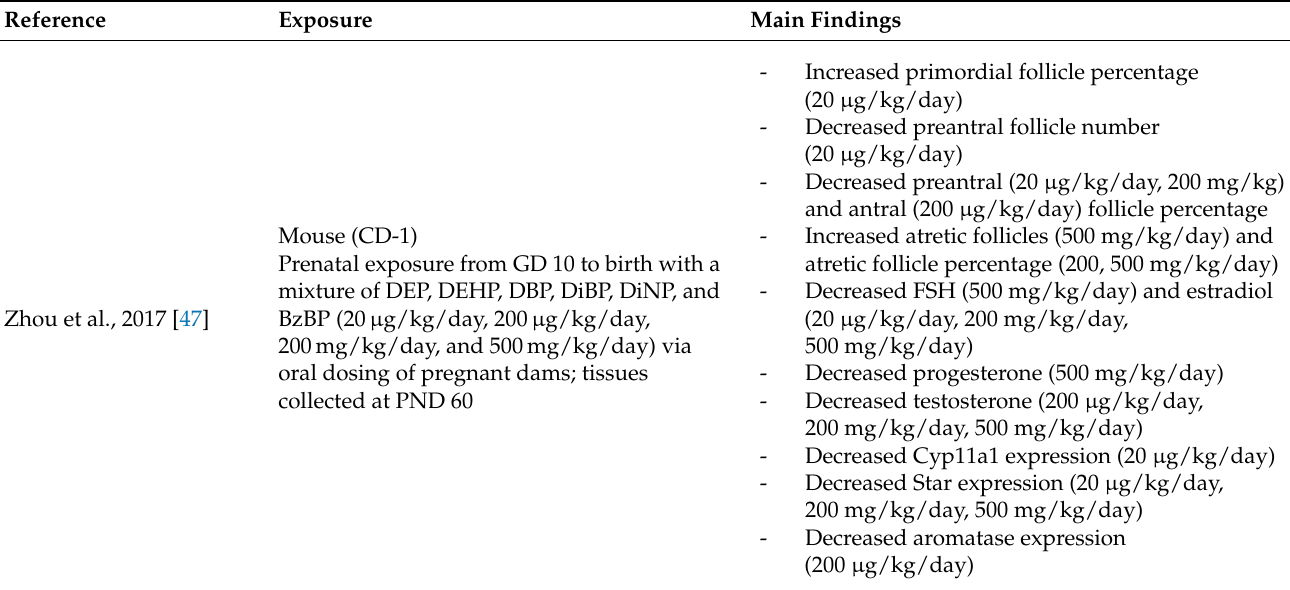
Table 2. Effects of prenatal exposure to phthalate mixtures on female